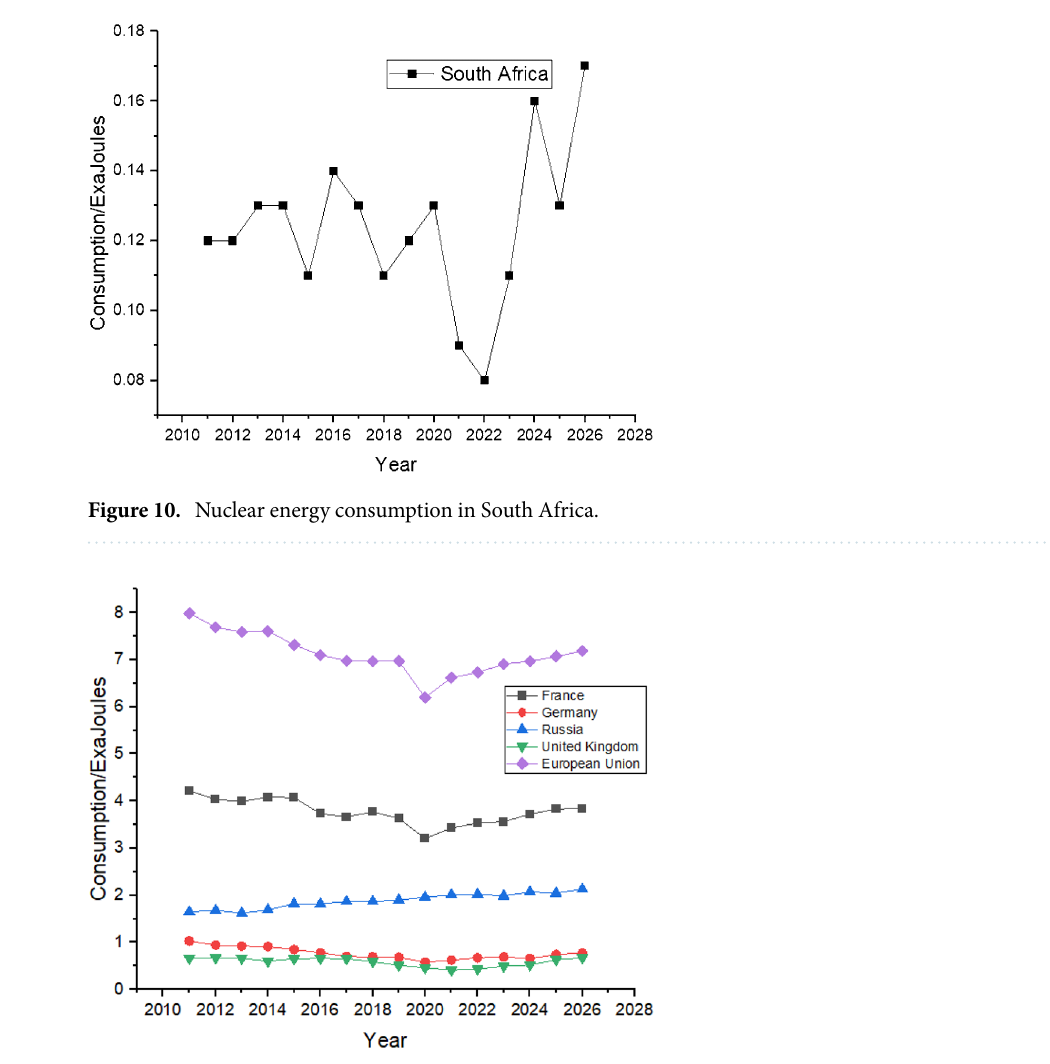
Figure 11. Nuclear energy consumption in European